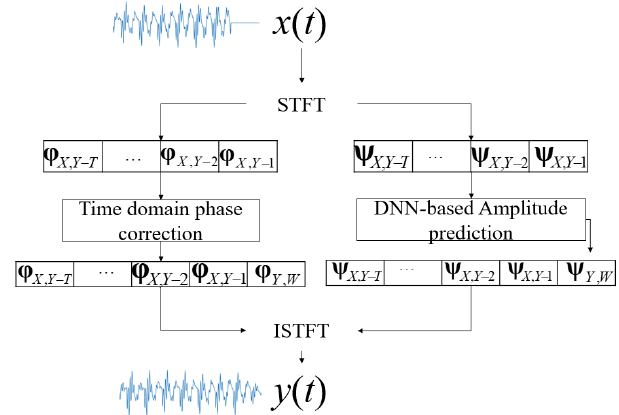
Figure 6. Illustration of time domain PLC method.